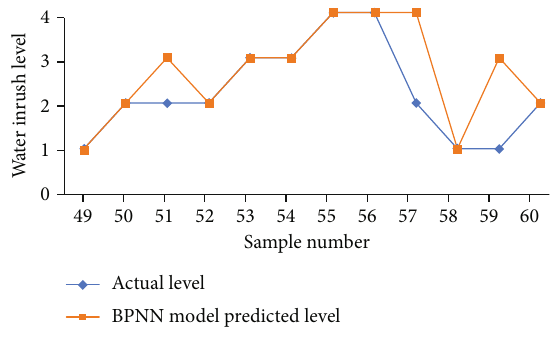
Figure 5: Prediction results of the BPNN model.